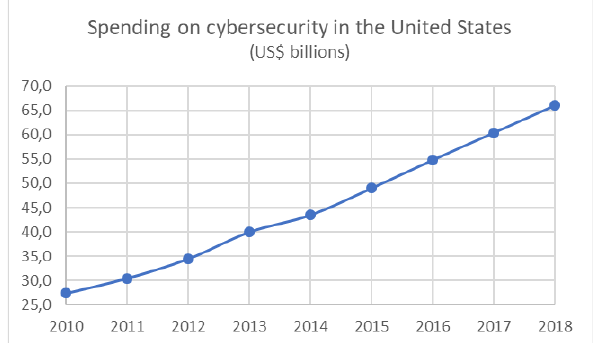
Figure 2. Annual spending on cybersecurity in the USA (data source: statista.com).